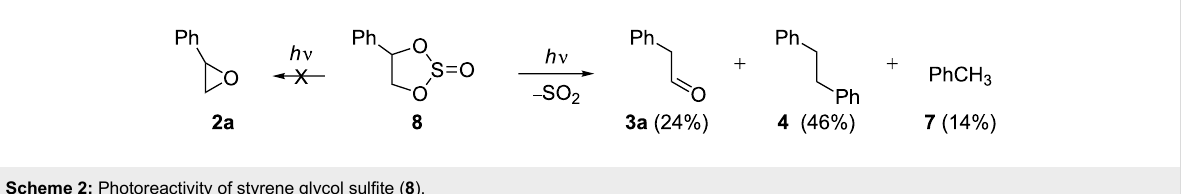
Scheme 2: Photoreactivity of styrene glycol sulfite ( 8